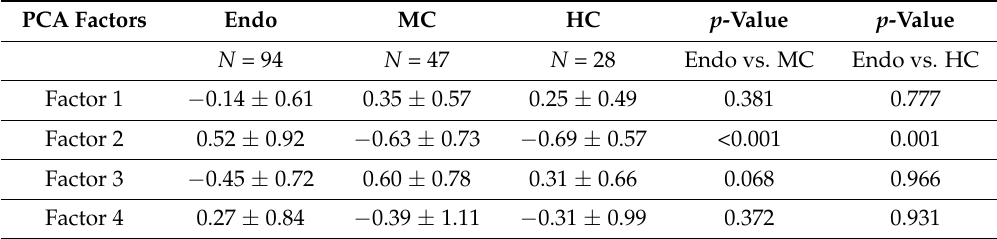
Endo = endometriosis, HC = healthy controls, MC = microscopic colitis. p -values were calculated using a general linear regression model where age was added as a covariate. Values are expressed as mean ± standard deviation of the sum of protein levels in each factor. p ≤ 0.01 was considered statistically